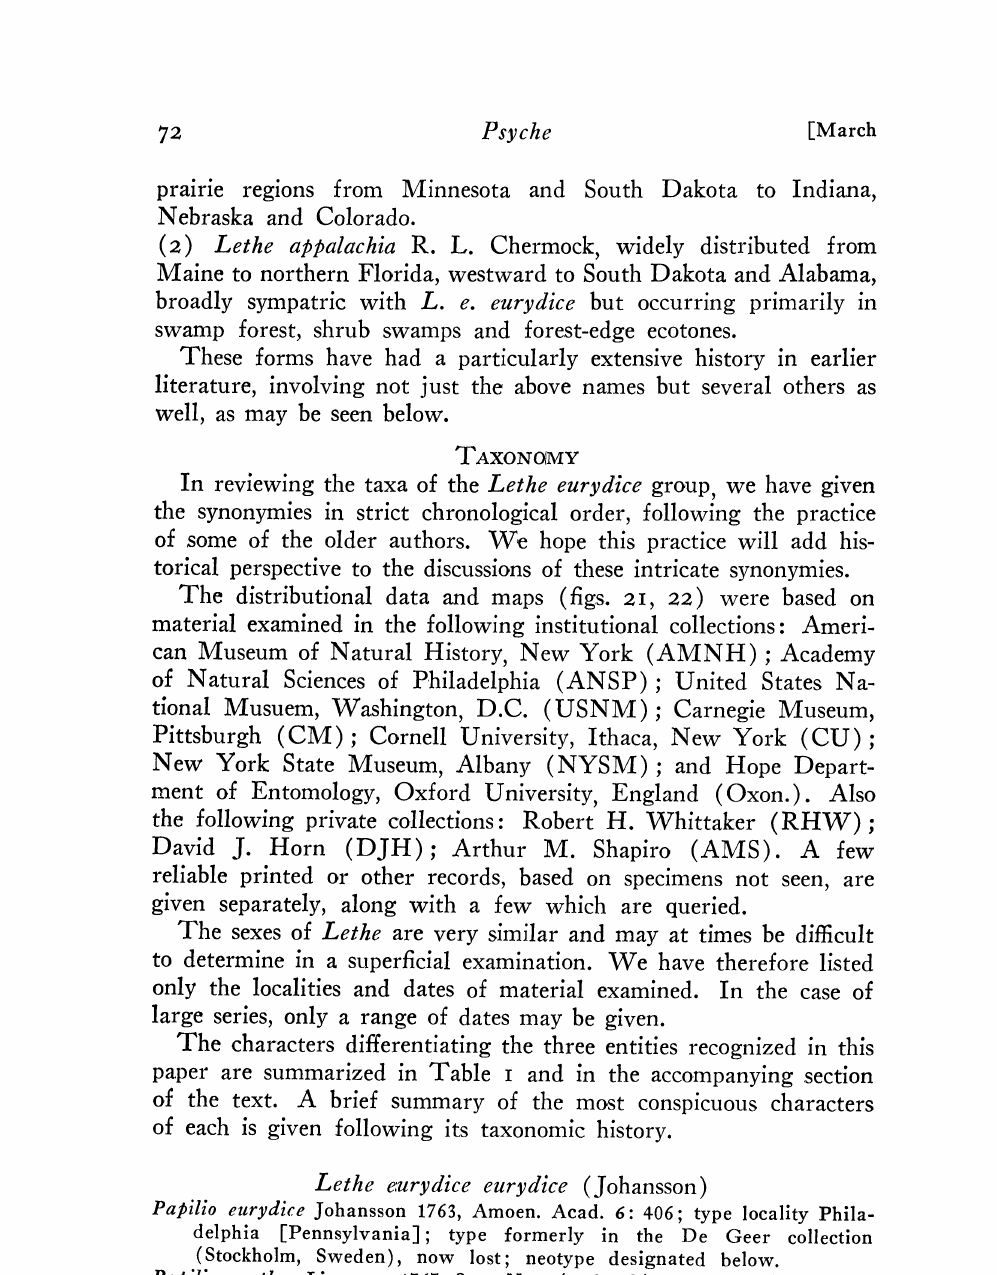
and in the accompanying .section o the text. A briet: summary o the most conspicuous characters o each is given ollowing its taxonomic